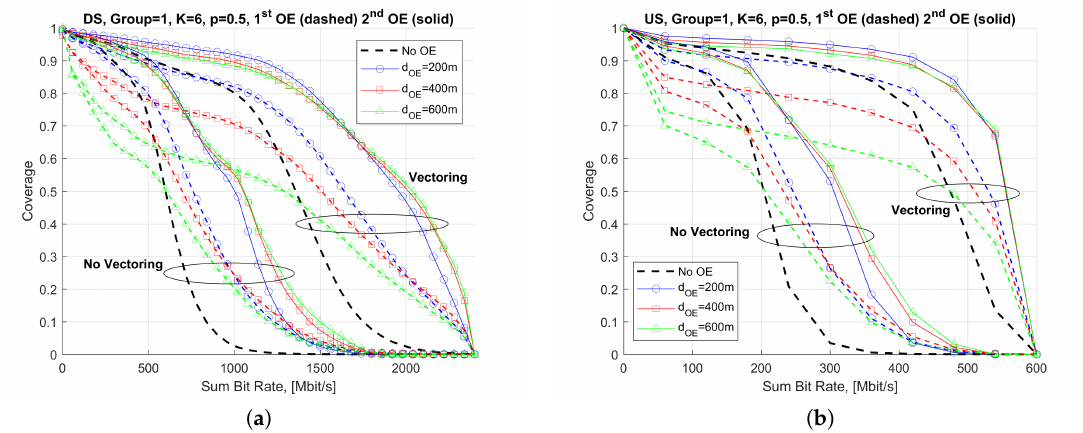
Figure 5. Sum bit rate coverage for group 1, d OE = 200,400,600 m—number of pairs assigned to each radio node K = 6, user activity factor p = 0.5, vectoring and non-vectoring: DS ( a ); US ( b